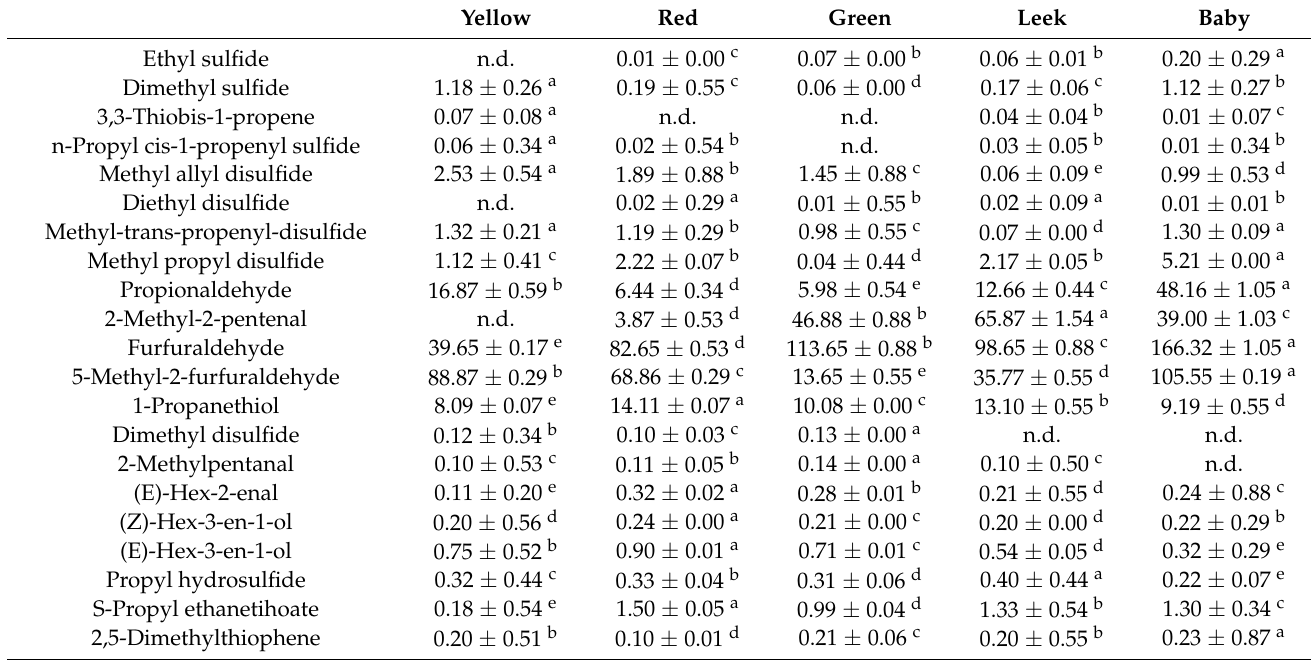
Table 2. Volatile compounds.